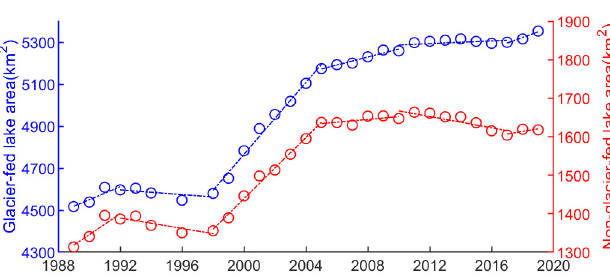
Figure 3. Comparison of areal variations for glacier-fed and non-glacier-fed lakes in 1989–2019.